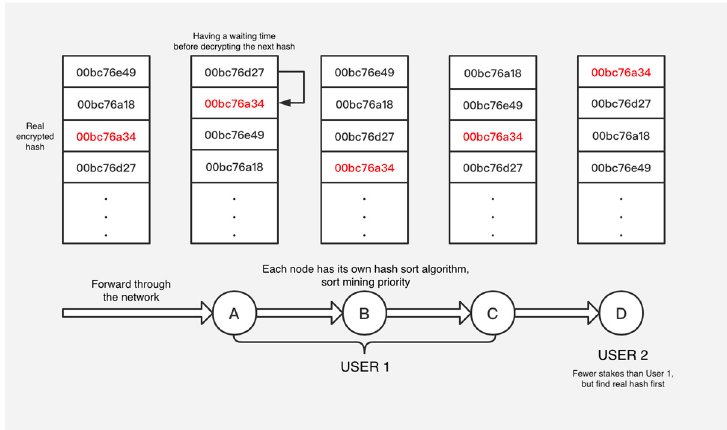
Figure 4. Overall structure of the PoP (Proof-of-Probability) algorithm.